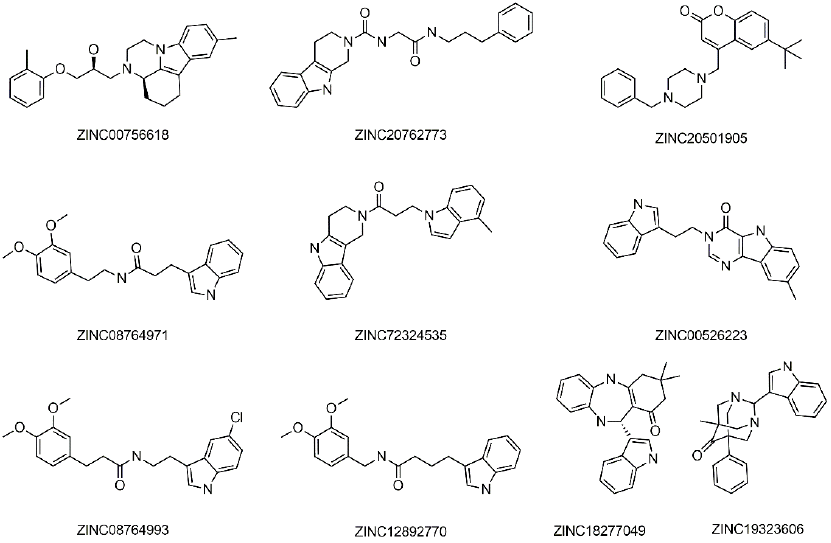
Figure 3. Structural formula of selected 5HT6 receptor candidates from ZINC database.